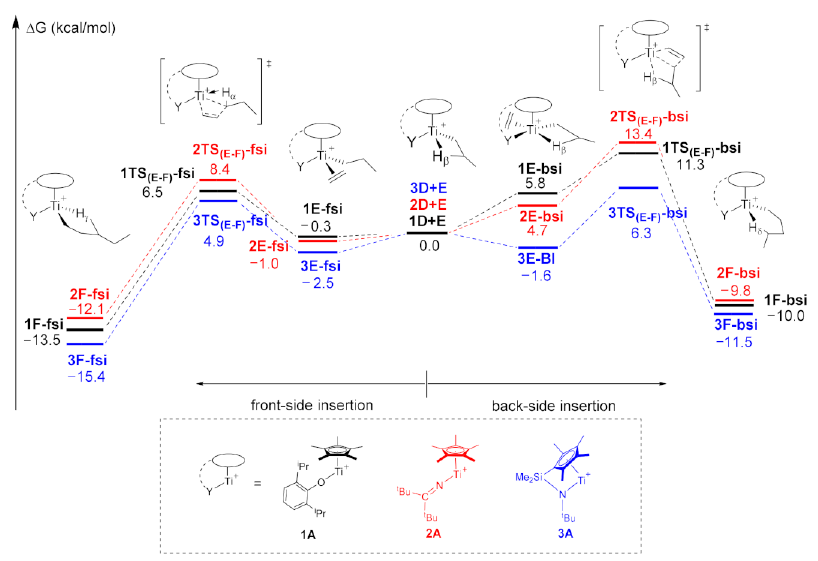
Figure 8. The calculated free energy profiles (energy in kcal/mol) for propagation stage of ethylene polymerization catalyzed by